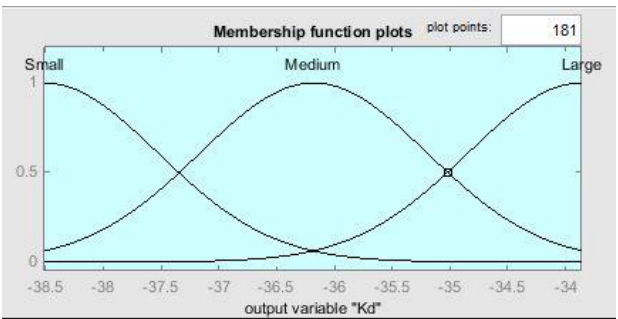
Fig. 10. Membership function for output Ki variable